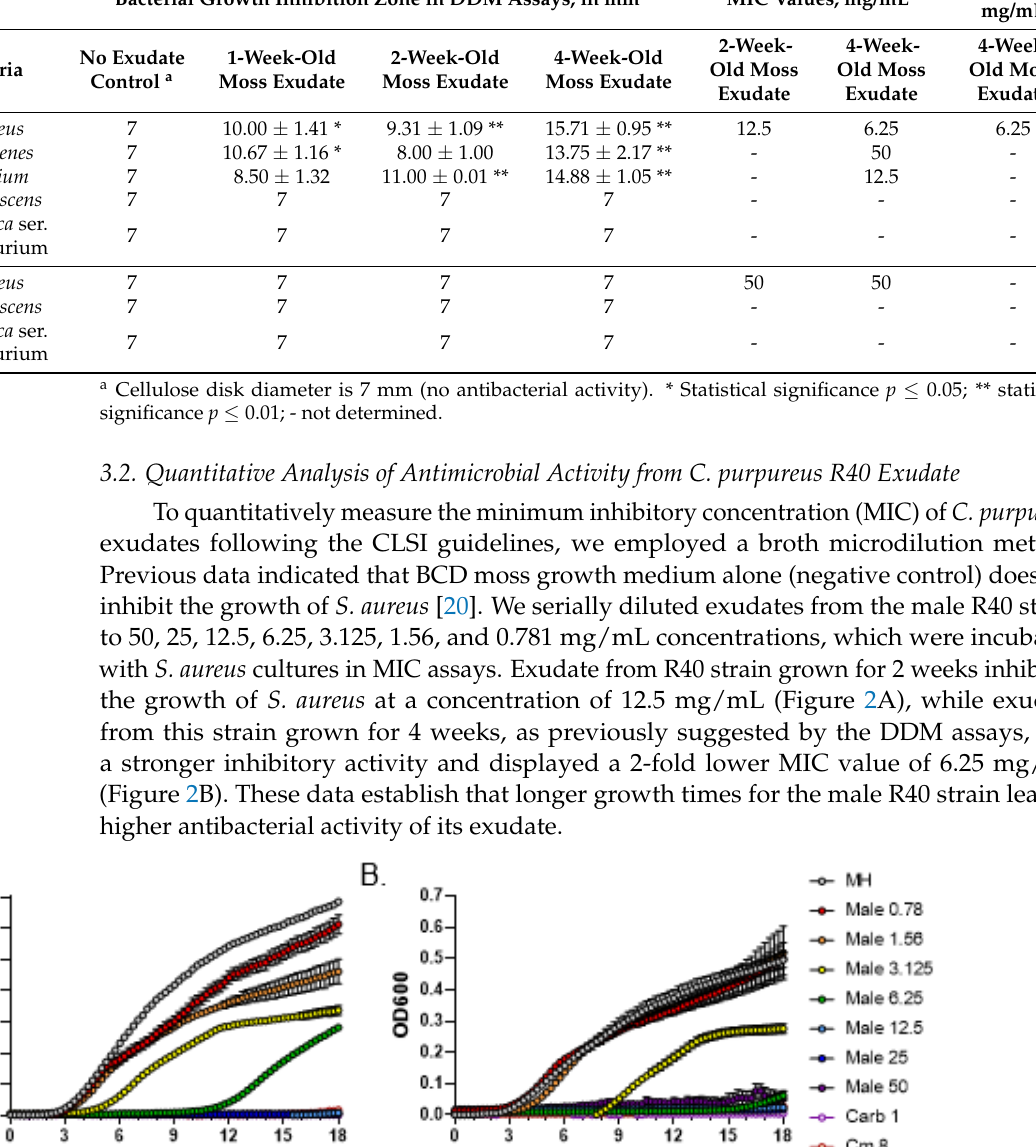
Table 1. Bacterial growth inhibition activity of C. purpureus exudates. Bacterial Growth Inhibition Zone in DDM Assays, in mm